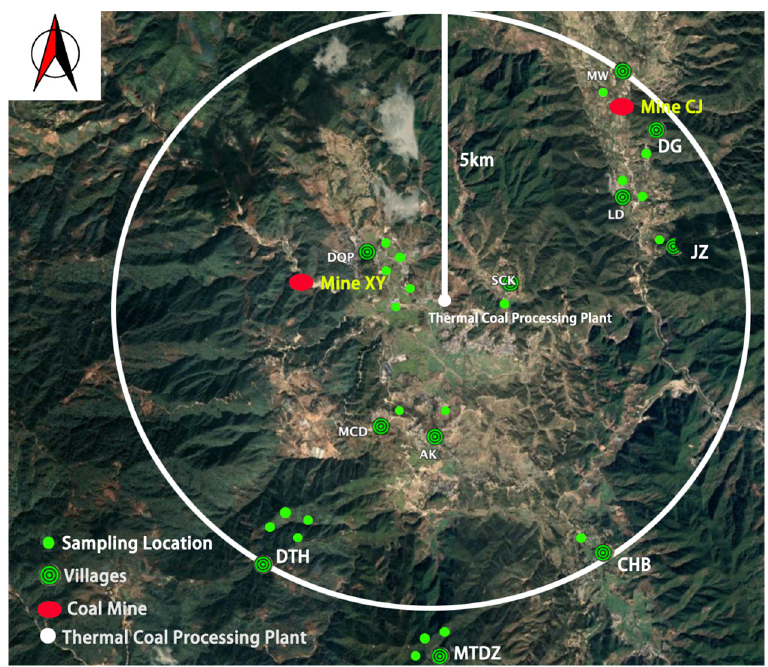
Figure 2. The locations of the sampling sites, coal mines and villages.